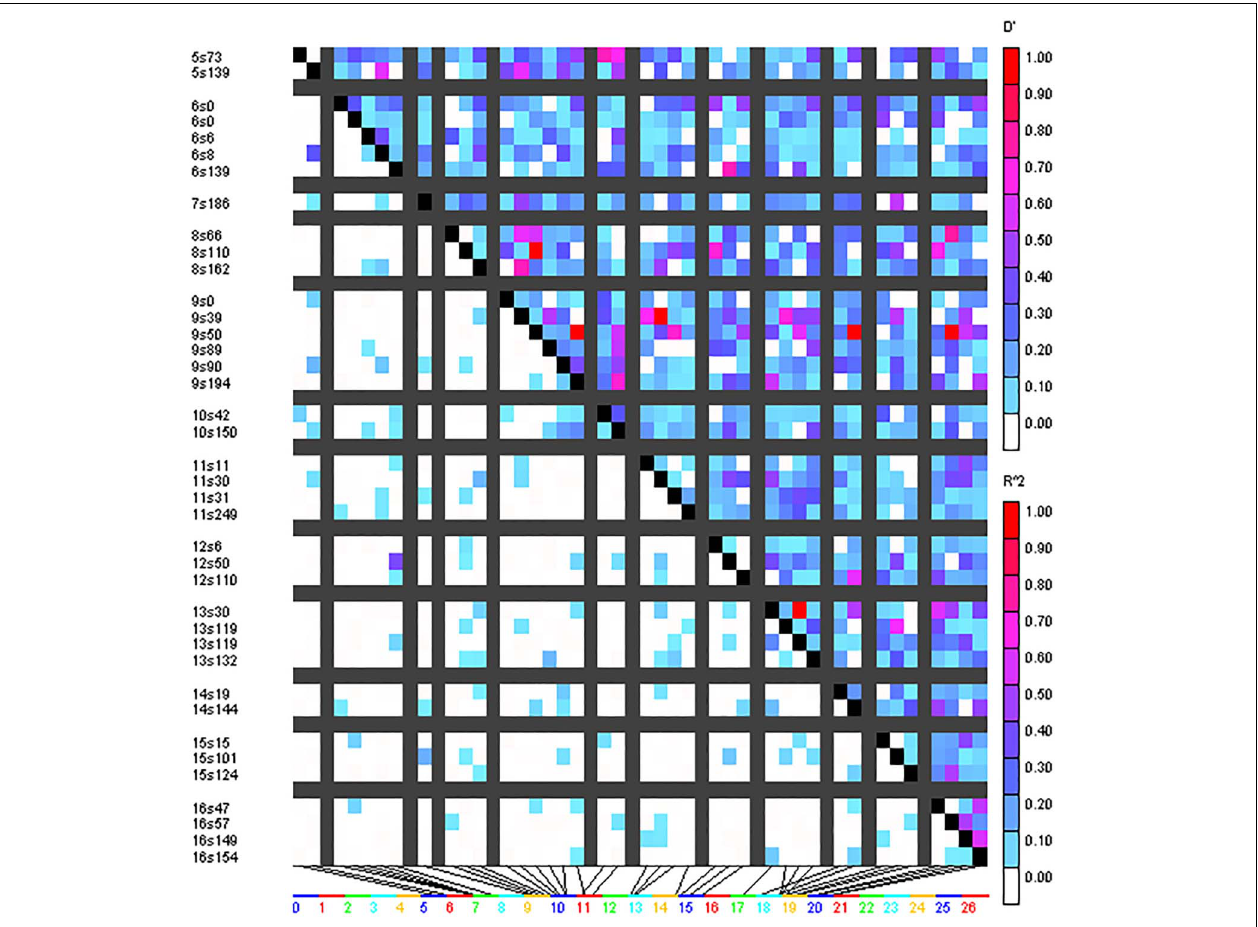
FIGURE 4 | Triangle heat plot showing pairwise value of D ’ and r 2 for different locus pair over different chromosomes of cotton in the present germplasm panel.